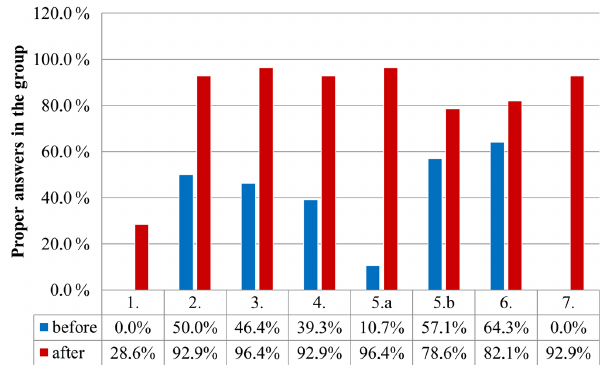
Figure 4. Distribution of primary effects of lightning strikes.